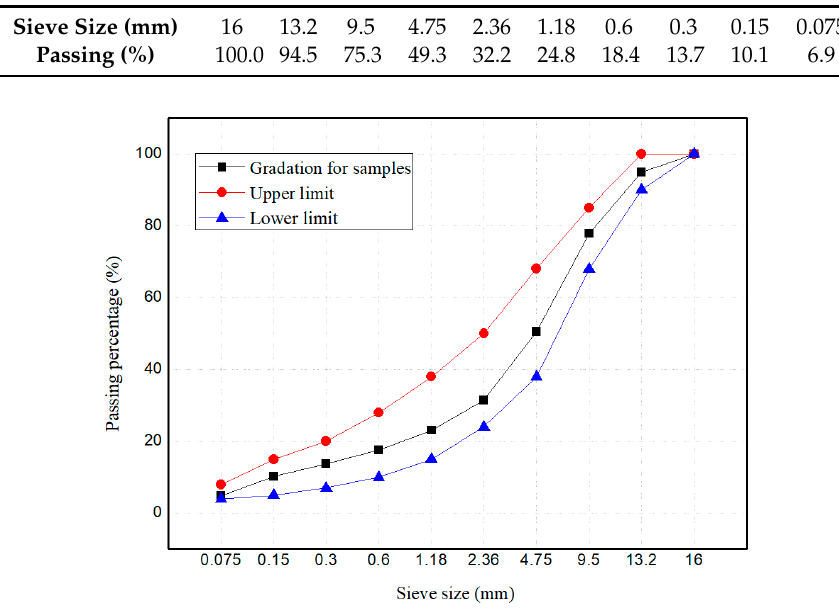
Table 6. Gradation of the asphalt mixture (AC-13).